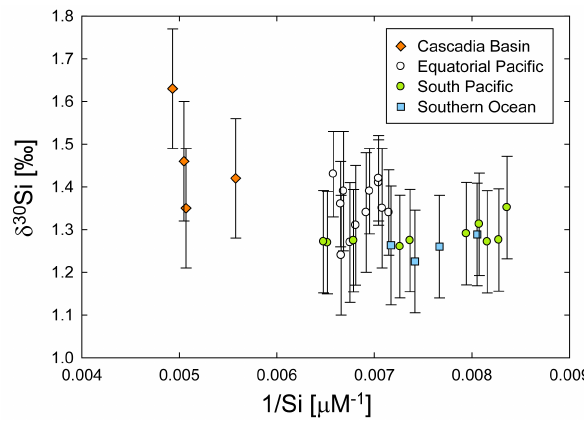
Fig. 8. A mixing diagram of δ 30 Si versus 1/[Si] showing deep waters from the Pacific sector of the Southern Ocean to the Cas- cadia Basin in the North Pacific (47 ◦ N). All deep water ( γ n ≥ 27 . 93kgm − 3 ) samples with [Si] equal to or higher than that of the deep inflow of CDW into the Pacific Ocean (120µM; e.g., War- ren, 1973) are included. Cascadia Basin and equatorial Pacific data are from Beucher et al. (2008, 2011); error bars correspond to ex- ternal reproducibilities reported by the authors. From the Equator southwards, any δ 30 Si variation is clearly at the limit of analytical resolution, especially considering that δ 30 Si offsets on the order of ± 0.1‰ between laboratories are possible (Reynolds et al.,